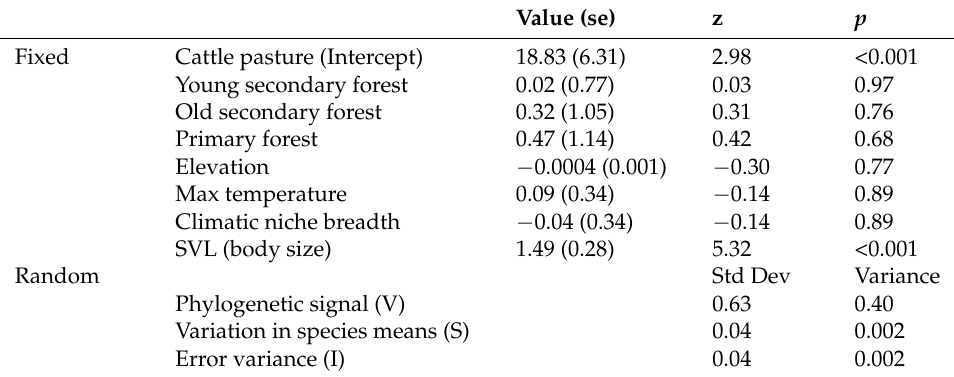
Table 1. Summary of linear mixed effect model of environmental and phylogenetic factors on CT max variation of 204 frog